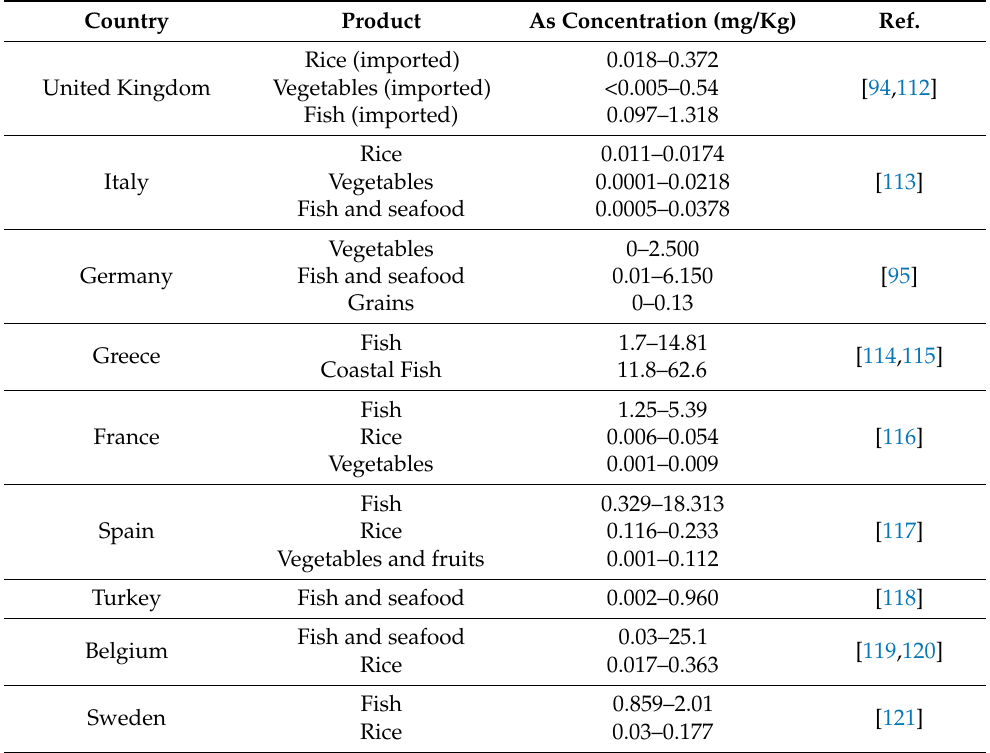
Table 4. Foods affected by arsenic contamination in Europe (data selected from recent literature).